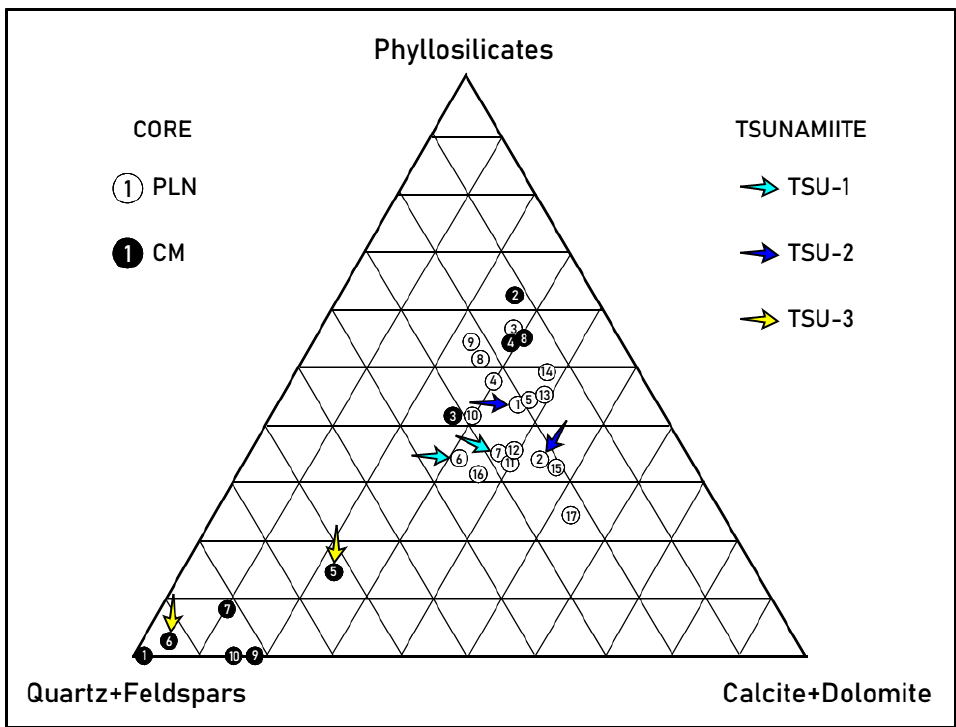
Figure 7. Mineralogy: triangular plot. Phyllosilicates are mostly formed by the following association: illite / mica-smectite > (kaolinite) [19].